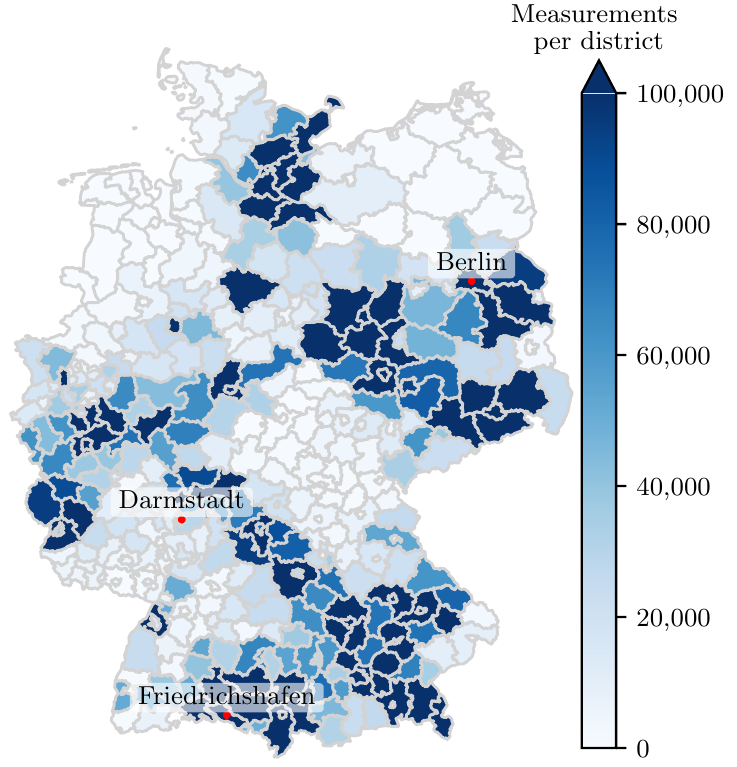
Figure 4. Map of Germany with the intensity of the color representing the amount of measurements per